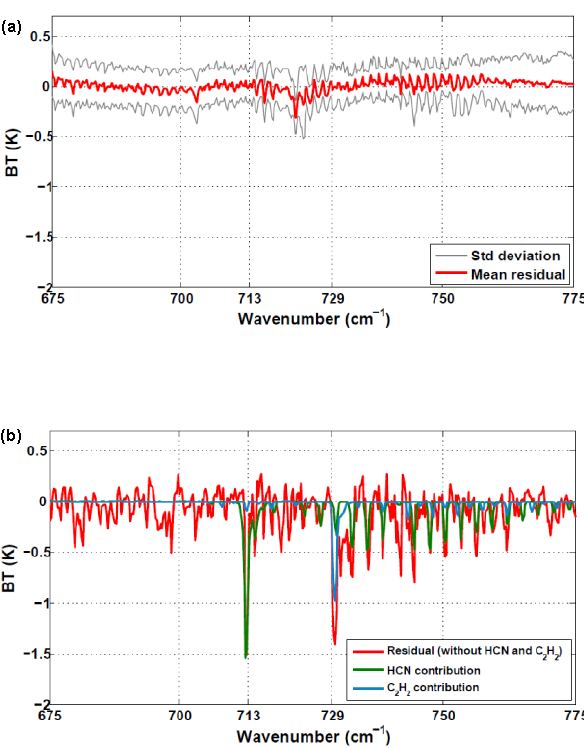
Fig. 2. (a) Residual averaged over the whole set of fits (red line) with its standard deviation (gray lines). (b) Difference (red line) be- tween an observed spectrum on 10 October 2010 at 22.35 ◦ S and 33.63 ◦ E and the corresponding fitted spectrum when HCN and C 2 H 2 have been excluded from the fit. The green and blue lines show the contributions at the top of the atmosphere of HCN and C 2 H 2 ,